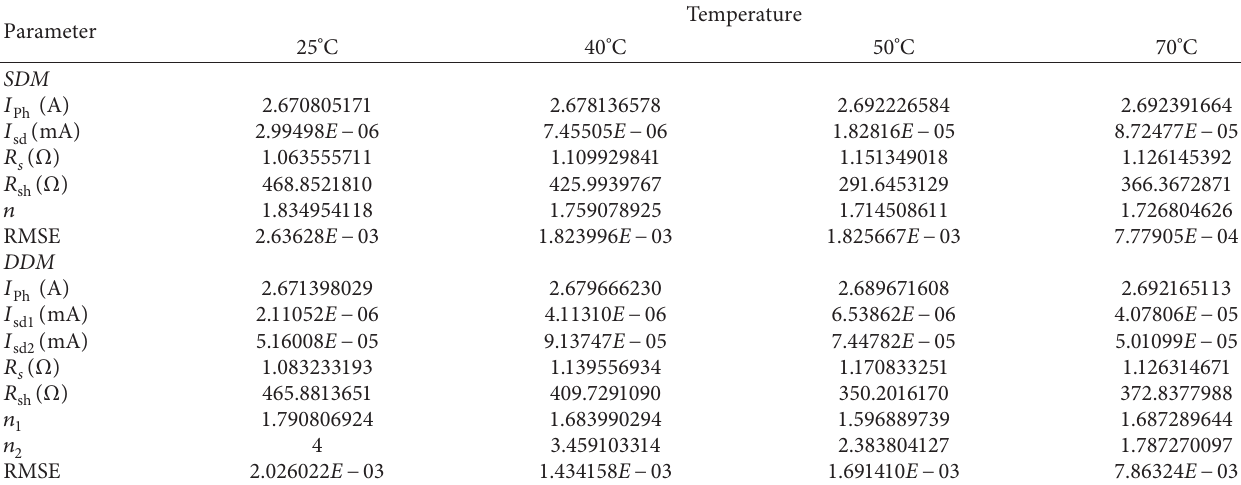
Table 12: The optimal extracted parameters for SM55 based on MWOA at various temperatures with irradiance of 1000 ( W/m 2 ) .